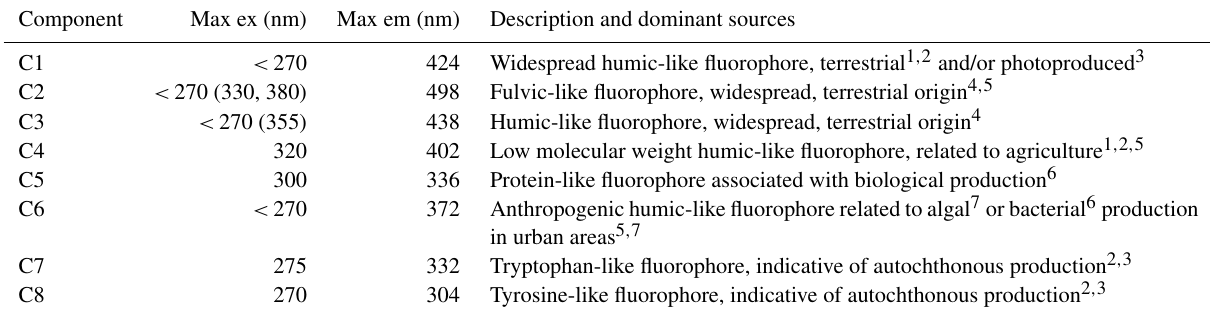
Table 2. Spectral properties (positions of maximum excitation (ex) and emission (em) peaks) of the eight PARARAC components identified in this study, general description and dominant sources based on previous studies.